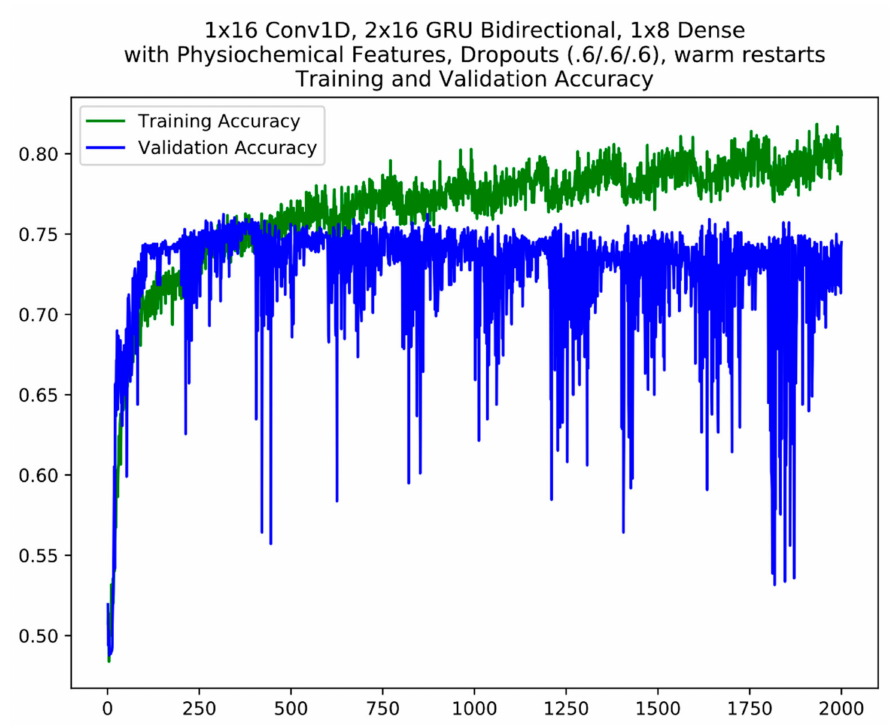
Figure 3. An example of model training using warm restarts. The cycles are apparent in the plot. The y axis is accuracy; the x axis is epochs.